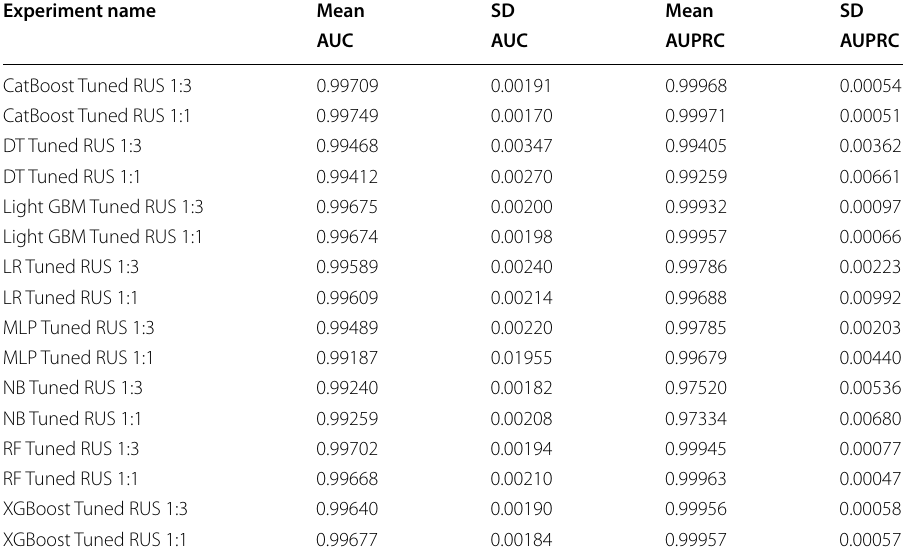
Table 34 Classification results for the keylogging dataset with sampling and tuned hyperparameters experiments; mean and standard deviations of AUC and AUPRC, (10 iterations of 5-fold